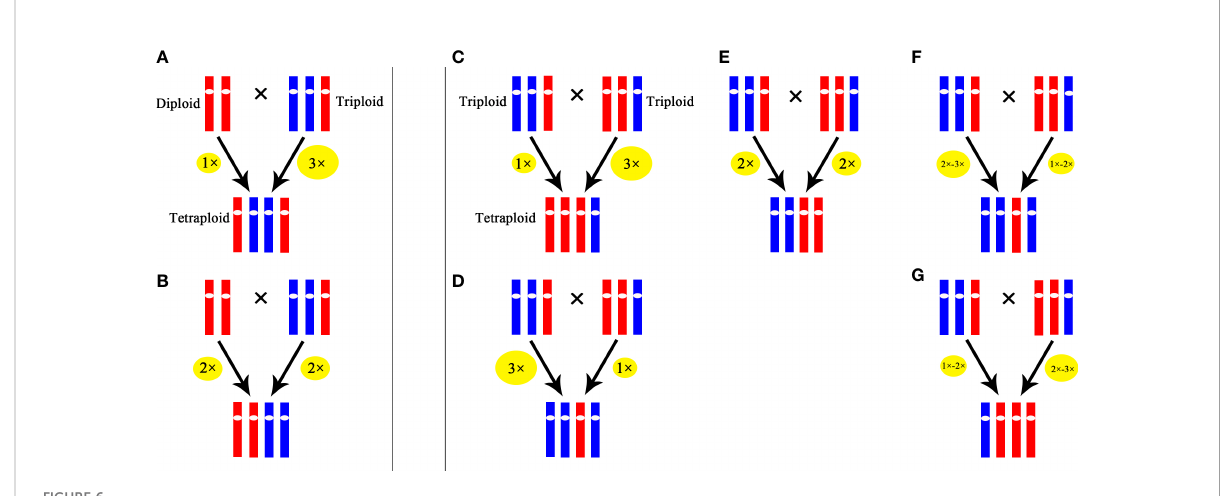
FIGURE 6 Possible pathways for producing tetraploid through ‘ triploid bridge ’ . (A) and (B) represent possible pathways in the cross of 2××3×. (C-G) represent possible pathways in the cross of 3××3×. The size of ellipse represents ploidy level of gamete, the larger the size is, the higher the ploidy level